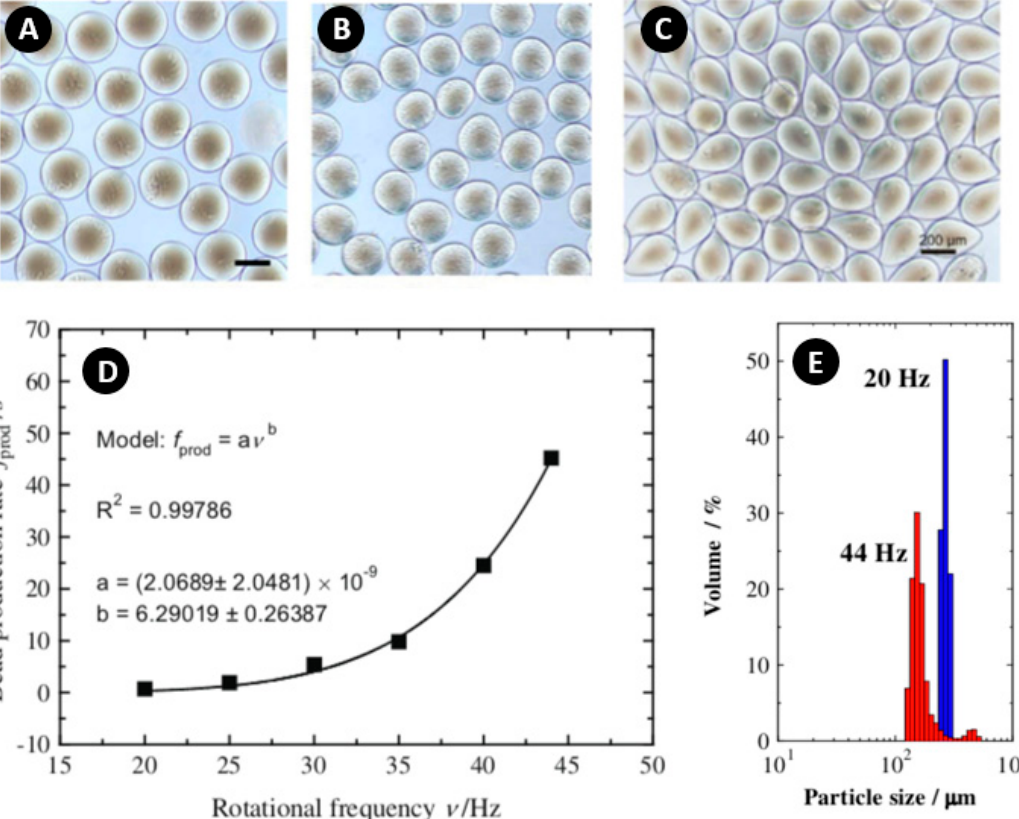
Figure 7. ( A – C ) Microscope images of beads. (A) 2% uniform particles of chitosan at 20 Hz; (B) 2% particles of chitosan at 25 Hz, smaller droplets retaining spherical shape; (C) 3% tear-like shape chitosan at 30 Hz; ( D ) Bead production rate at different rotational frequencies; ( E ) Size distribution histogram at 20 and 44 Hz with 2% chitosan. Reprinted with permission from [115].